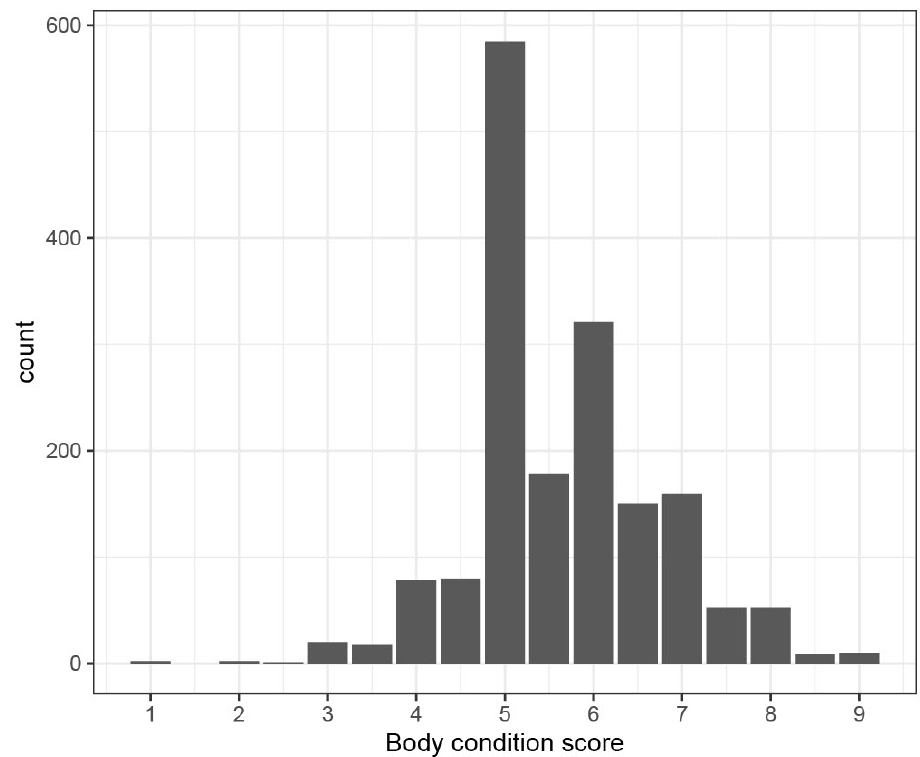
Figure 3. The distribution of body condition scores of 1716 horses using the 1–9 scale [18].